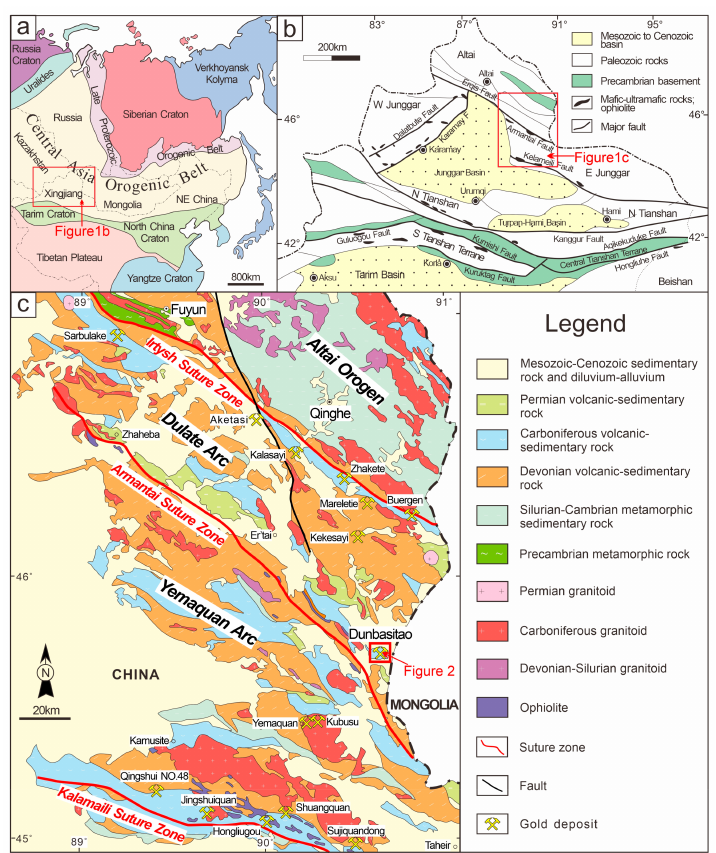
Figure 1. Tectonic locations of East Junggar and Dunbasitao gold deposit (according to Liu et al. [35]). ( a ) Simplified tectonic map of the Central Asian Orogenic Belt showing the location of North Xinjiang. ( b ) Simplified geological map showing the division of tectonic units in North Xinjiang. ( c ) Regional ge- ological map of the northern part of East Junggar showing the location of the Dunbasitao gold